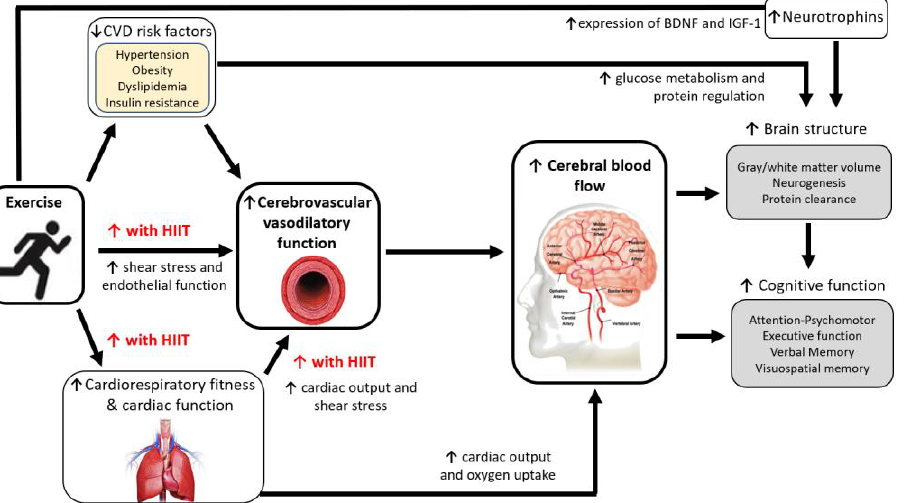
Figure 1. Potential mechanisms for how high intensity exercise can improve brain health. Abbreviations: BDNF: brain-derived neurotrophic factor; CVD: Cardiovascular disease; HIIT: high intensity interval training; IGF-1: insulin-like growth factor 1; ↑: increase, ↓: decrease.